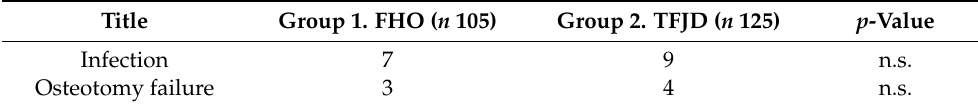
Table 2. Infection and acute osteotomy